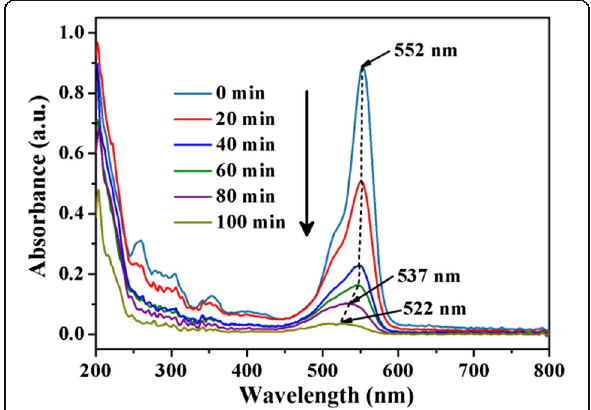
Fig. 7 The optical adsorption spectra changes of RhB solution degradation over the WS 2 /Bi 2 MoO 6 composite (5 wt%)